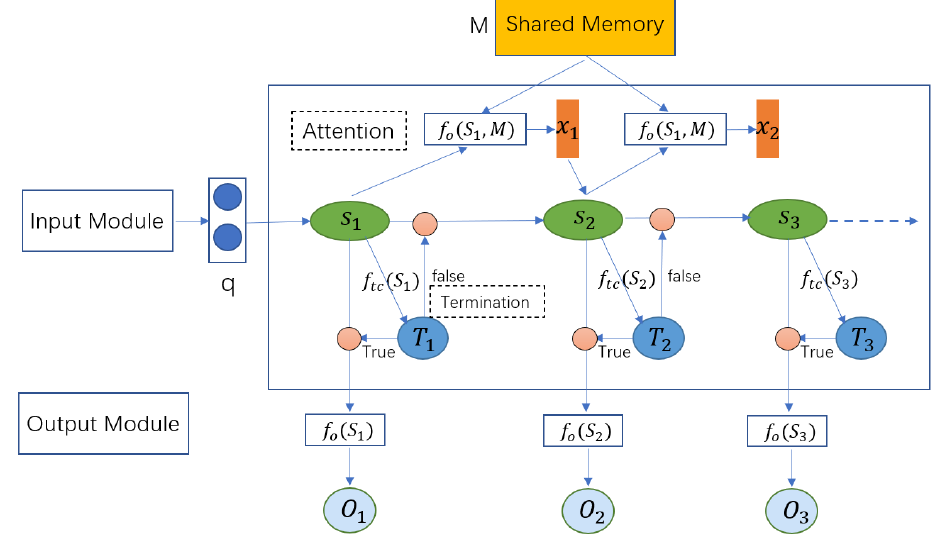
Figure 10. The structure of IRN model. The input module takes a query and converts the query into a vector representation q. The output module is a function f o , which converts the hidden state received from the search controller(s) into an output O